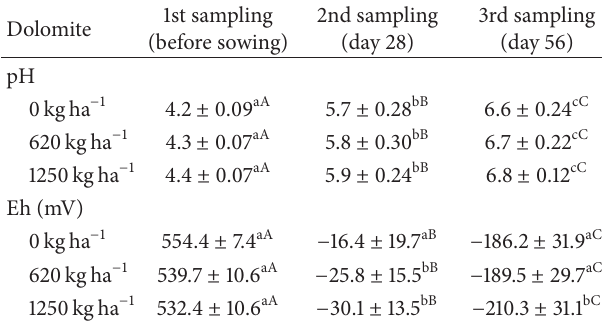
Table 1: Mean ± standard deviation for pH and Eh at three sampling dates and on three different lime treatments. (Mean values followed by a diffferent lowercase letter in the column and different capital letter in the row are significantly